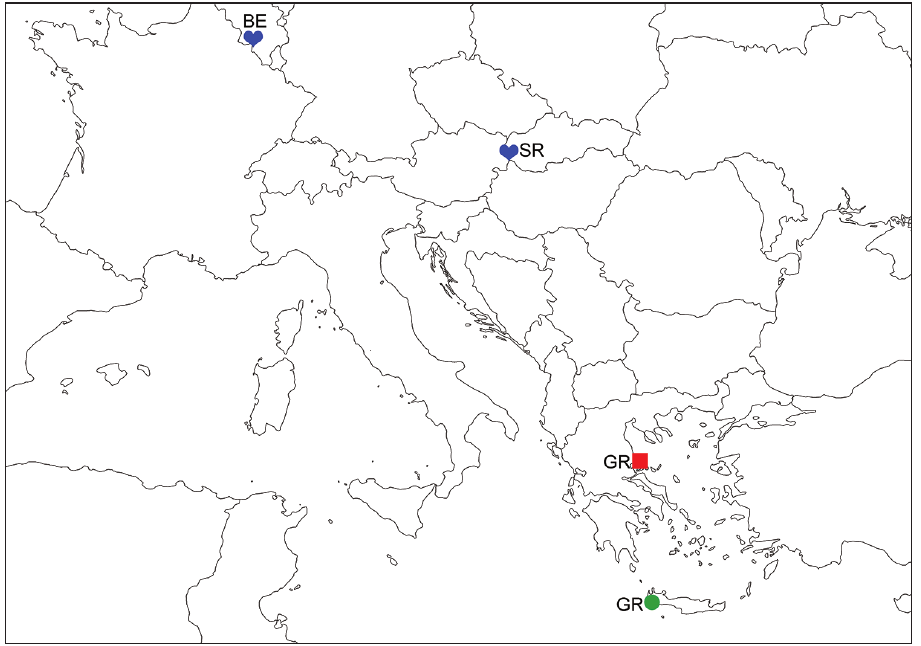
Figure 1. Collection localities of the studied material: Lasiochernes cretonatus (green circle), L . jonicus (red square) and L . pilosus (blue